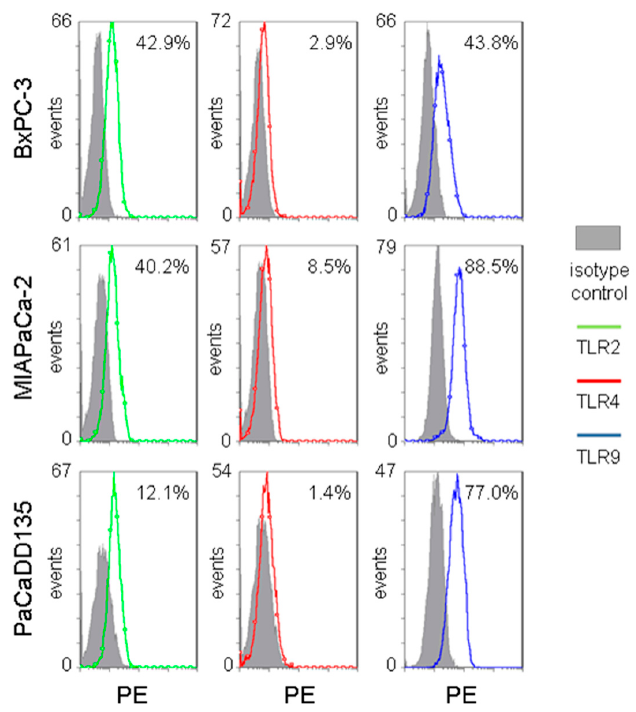
Figure 5. Distribution of TLR2, -4, and -9 expressing cells in pancreatic cancer cell lines. Flow cytometric analysis of BxPC-3, MIAPaCa-2, and PaCaDD135 using PE-conjugated antibodies against TLR2, -4, and -9. TLR2 depicted as green line, TLR4 as red line, and TLR9 as blue line, isotype control as grey area, PE (phycoerythrin).